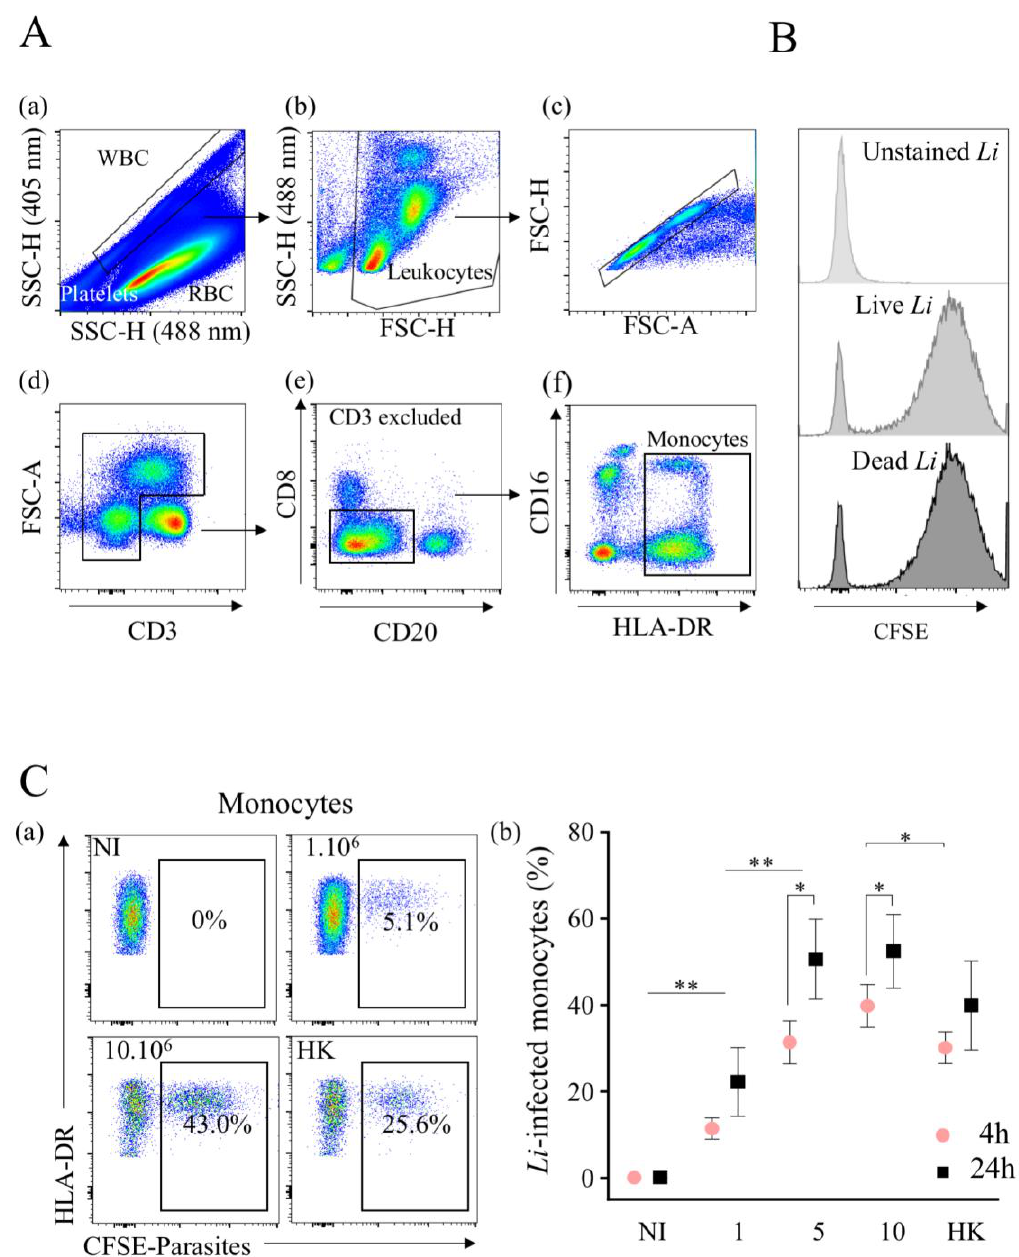
Figure 1. Leishmania infantum infects primary human monocytes in whole blood. ( A ) Immunophe- notyping of whole blood from healthy donors was conducted using a No-Wash No-lyse flow cy- tometric approach. Here, it was the representative gating strategy. Platelets and red blood cells were excluded by combining side scatter plot (SSC) of 405 nm and 488 nm lasers ( a ). Leukocytes were visualized on FSC against SSC plot ( b ), and singlet cells ( c ) were selected for further gating. ( d ) Lymphocytes expressing CD3 were excluded as well ( e ), CD8 (NK) and CD20 (B cells) populations; ( f ) on CD8 neg CD20 neg population, we analyzed the expression of CD16 against HLA-DR (monocytes). ( B ) CFSE intensity of live and dead parasites in myeloid cells. For comparison, unstained parasite is shown. ( C ) ( a ) Flow cytometry of CFSE-labeled Leishmania infantum in non-infected (NI) and infected monocytes with different quantities (1 × 10 6 , 5 × 10 6 and 10 × 10 6 /mL noted 1, 5 and 10, respectively) of live or heat-killed (HK, 10 × 10 6 /mL) parasites. ( b ) The percentages of infection at 4 and 24 h are shown. Data are the mean of 7 donors. Statistical analysis was performed using one-tailed Wilcoxon test (* p < 0.05, ** p < 0.01, n =